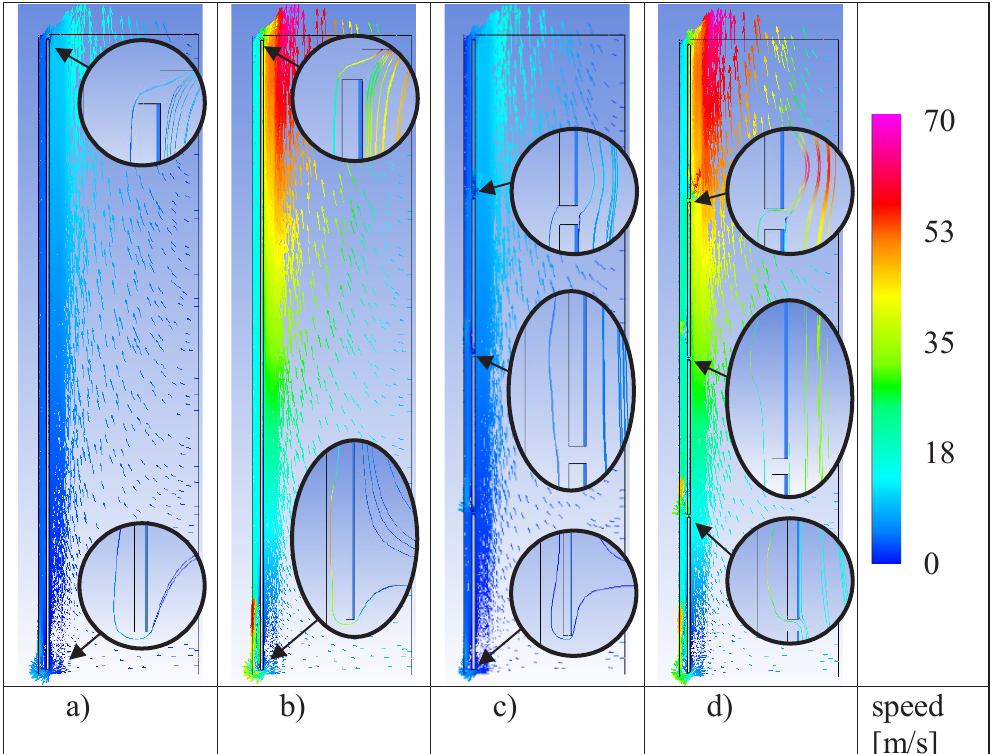
Figure 7: Airflow for individual numerical models: a) closed joint: 2.5 m/s; b) closed joint: 10 m/s; c) open joint: 2.5 m/s; d) open joint: 10